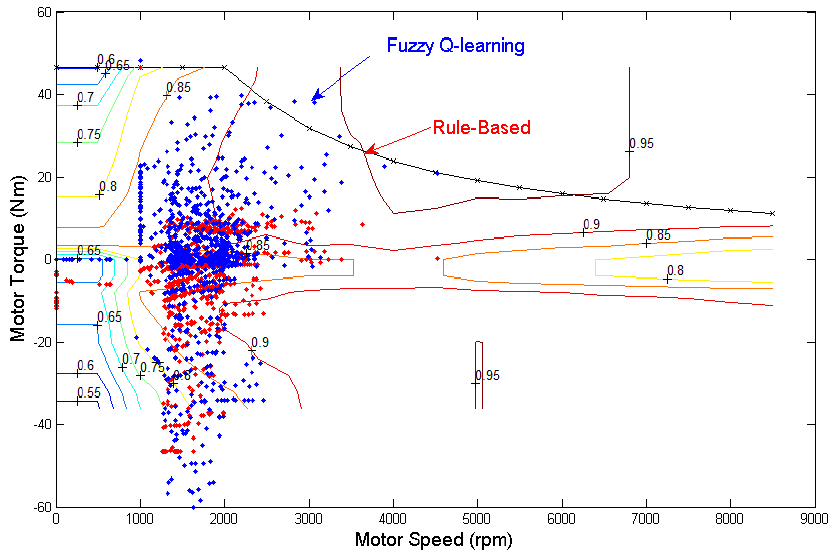
Figure 11. Motor operation point distribution under UDDS.